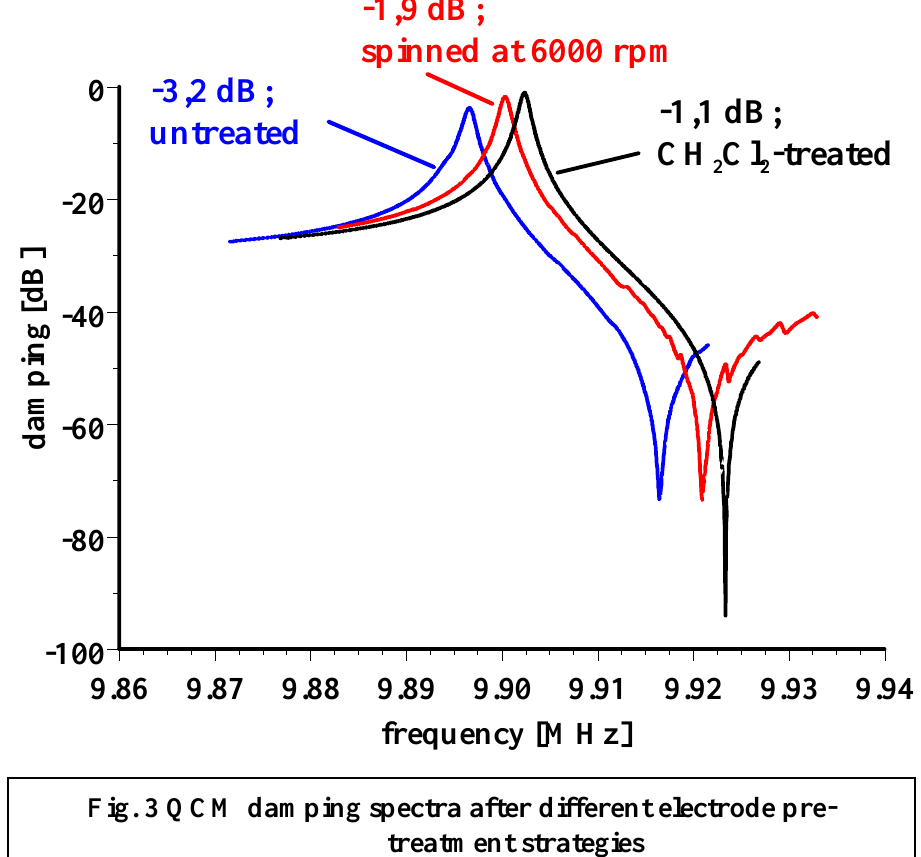
Fig. 3 QCM damping spectra after different electrode pre- treatment strategies